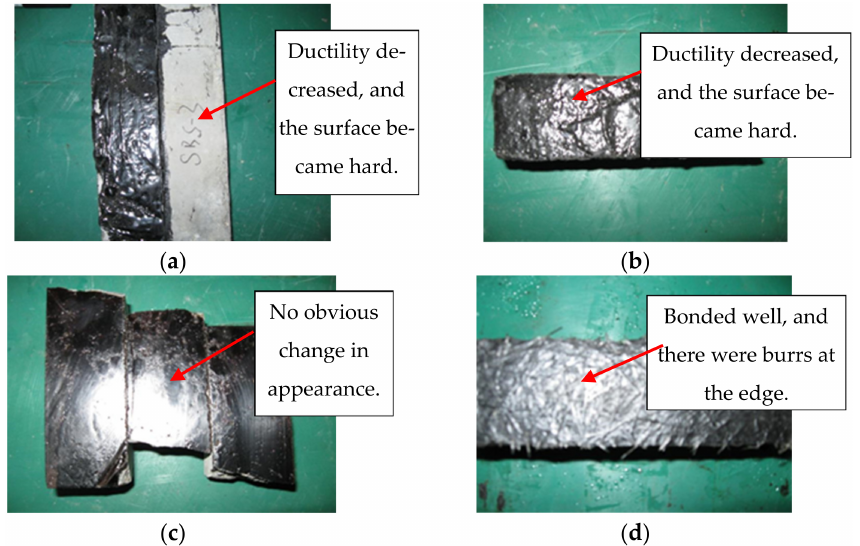
Figure 10. Specimen after corrosion resistance test. ( a ) Results of scheme I. ( b ) Results of scheme II. ( c ) Results of scheme III. ( d ) Results of scheme